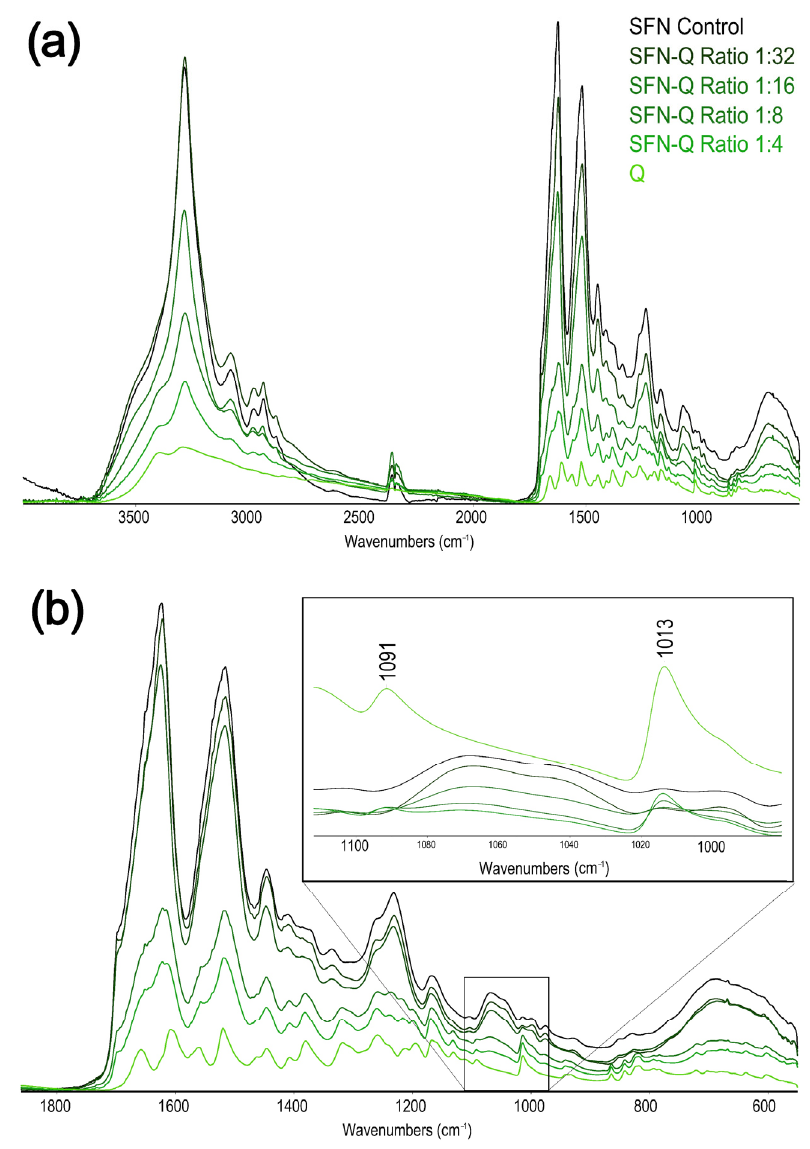
Figure 6. ATR-FTIR spectra of the prepared SFN-Q at different Q/SFN ratios. ( a ) Full spectra. ( b ) Region 1800–600 cm − 1 of the spectra with an inset of the region 1750–100 cm − 1 highlighting the quercetin signals.